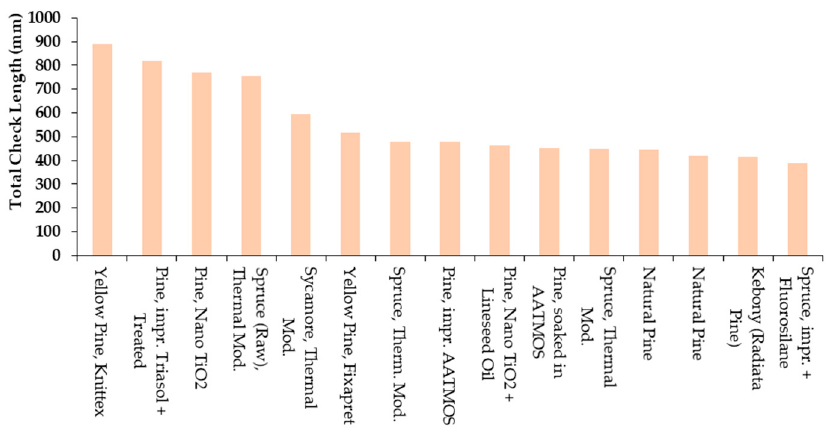
Forests 2020 , 11 , x FOR PEER REVIEW Figure 7. Materials with the longest total checks after 24 months of weathering.